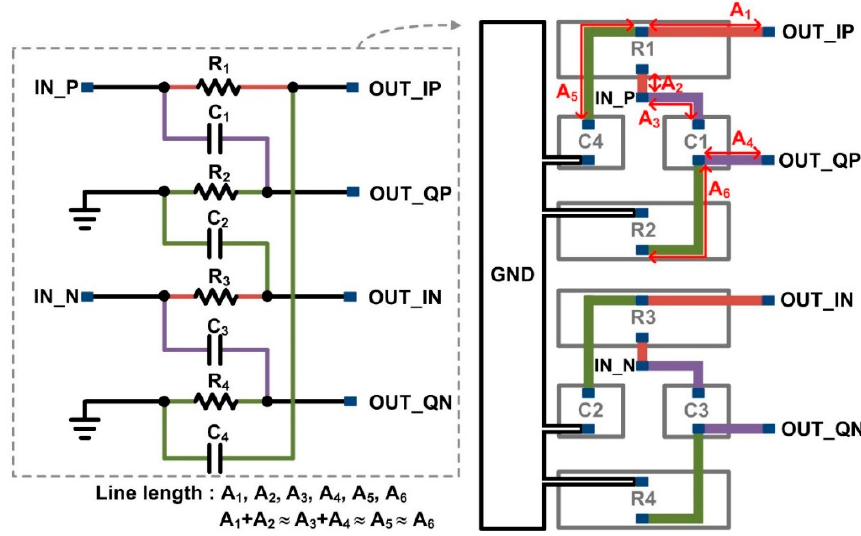
Figure 6. Simplified 1st - order poly-phase filter including parasitic line inductance by metal routing.